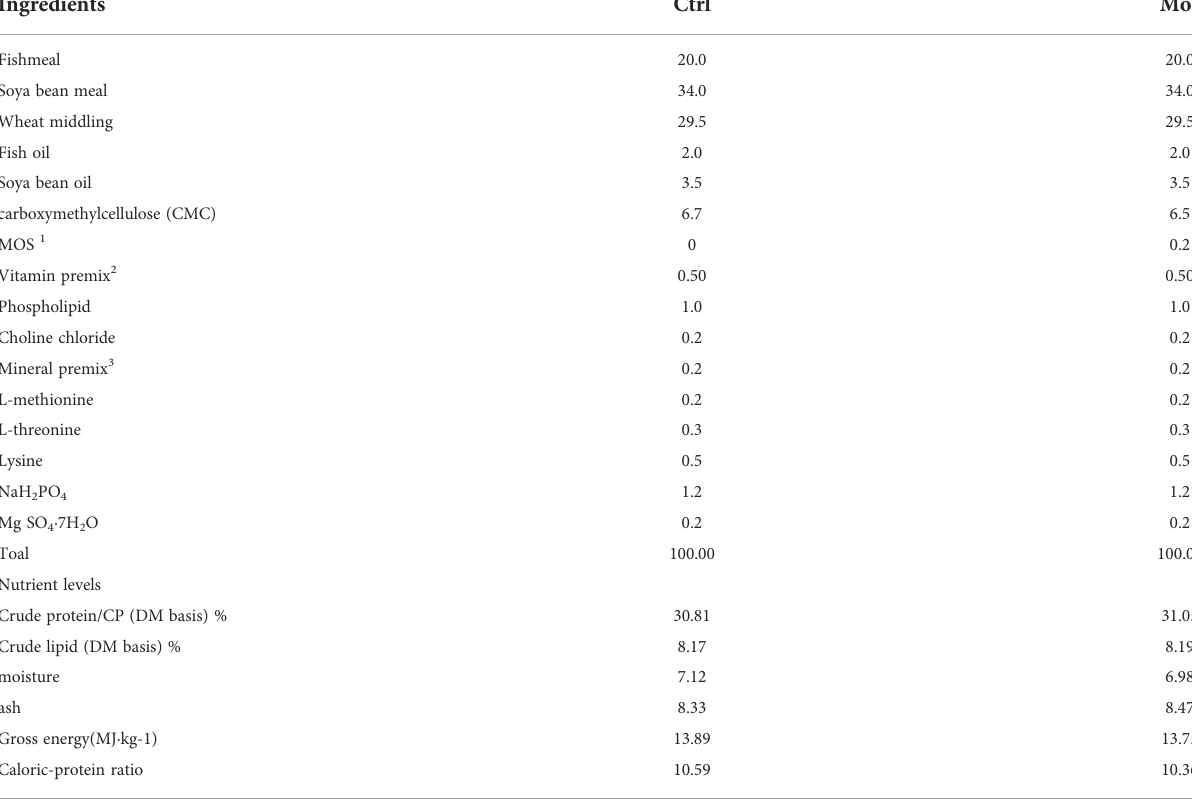
TABLE 1 Ingredients and approximate composition of the basal and experimental diet (DM basis) %.